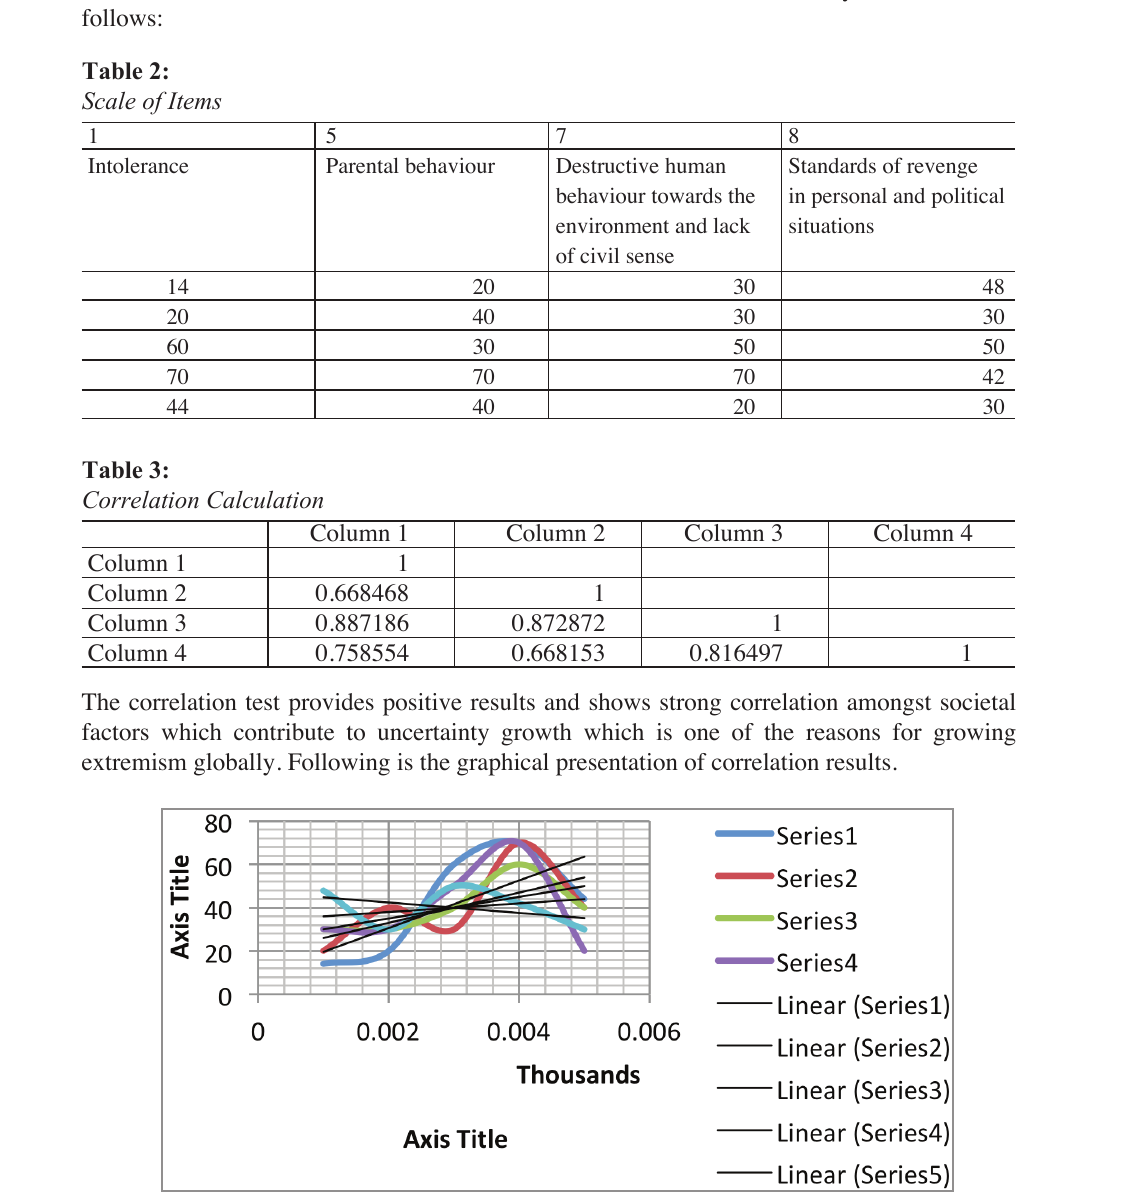
Figure 3: Graphical Presentation of Correlation